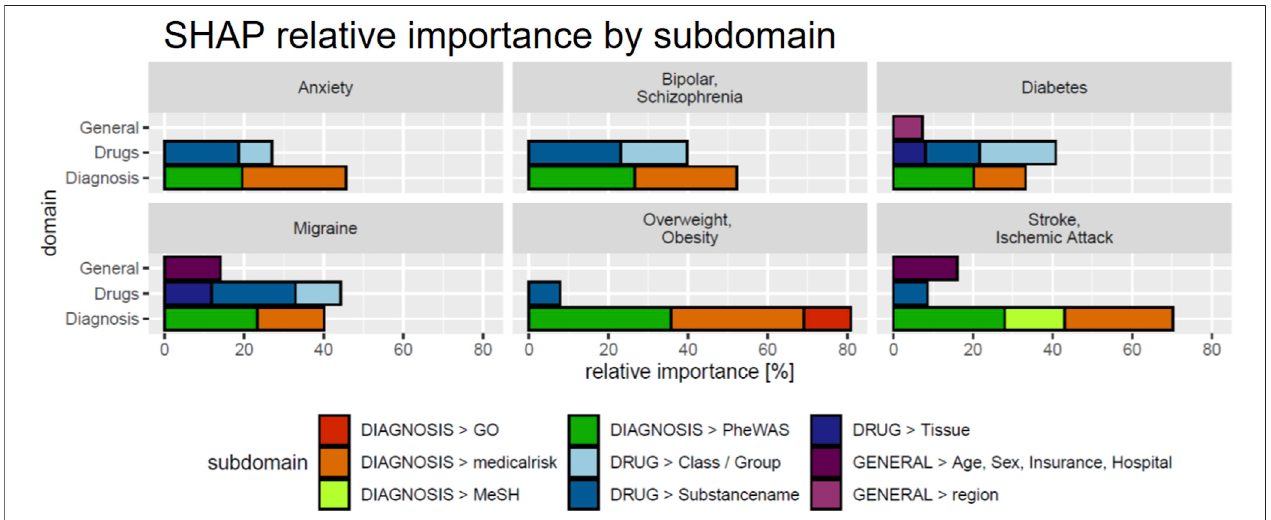
FIGURE 7 | SHAP values by feature subdomain. Subdomains with a cumulative relative importance ≤ 5% are not